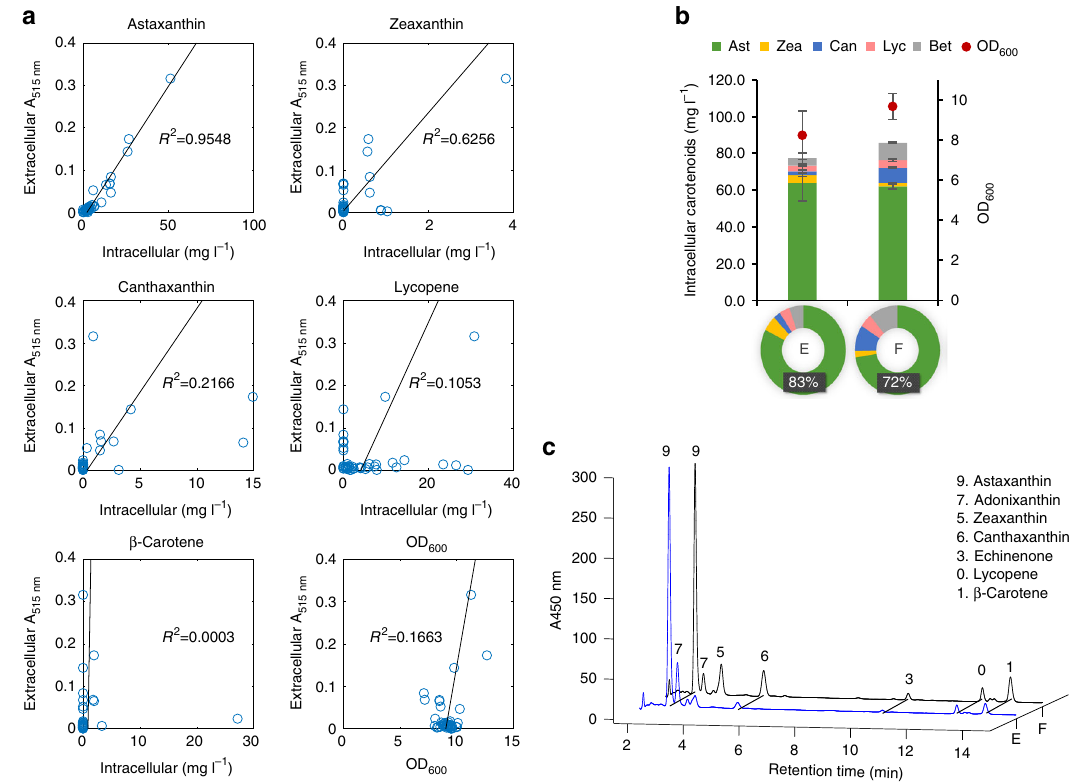
Fig. 6 Identi fi cation of extracellular carotenoids for screening. a Correlation between the medium absorbance at 515 nm (A515) and intracellular carotenoid concentration or cell density (OD 600 ). Among them, astaxanthin concentration was most strongly correlated with the medium absorbance. b The astaxanthin titers and cell density of the two strains, E and F, identi fi ed using the medium absorbance as the screening indicator. Error bars, mean ± s.d., n = 3. c The HPLC chromatograms of carotenoids produced in the strains E and